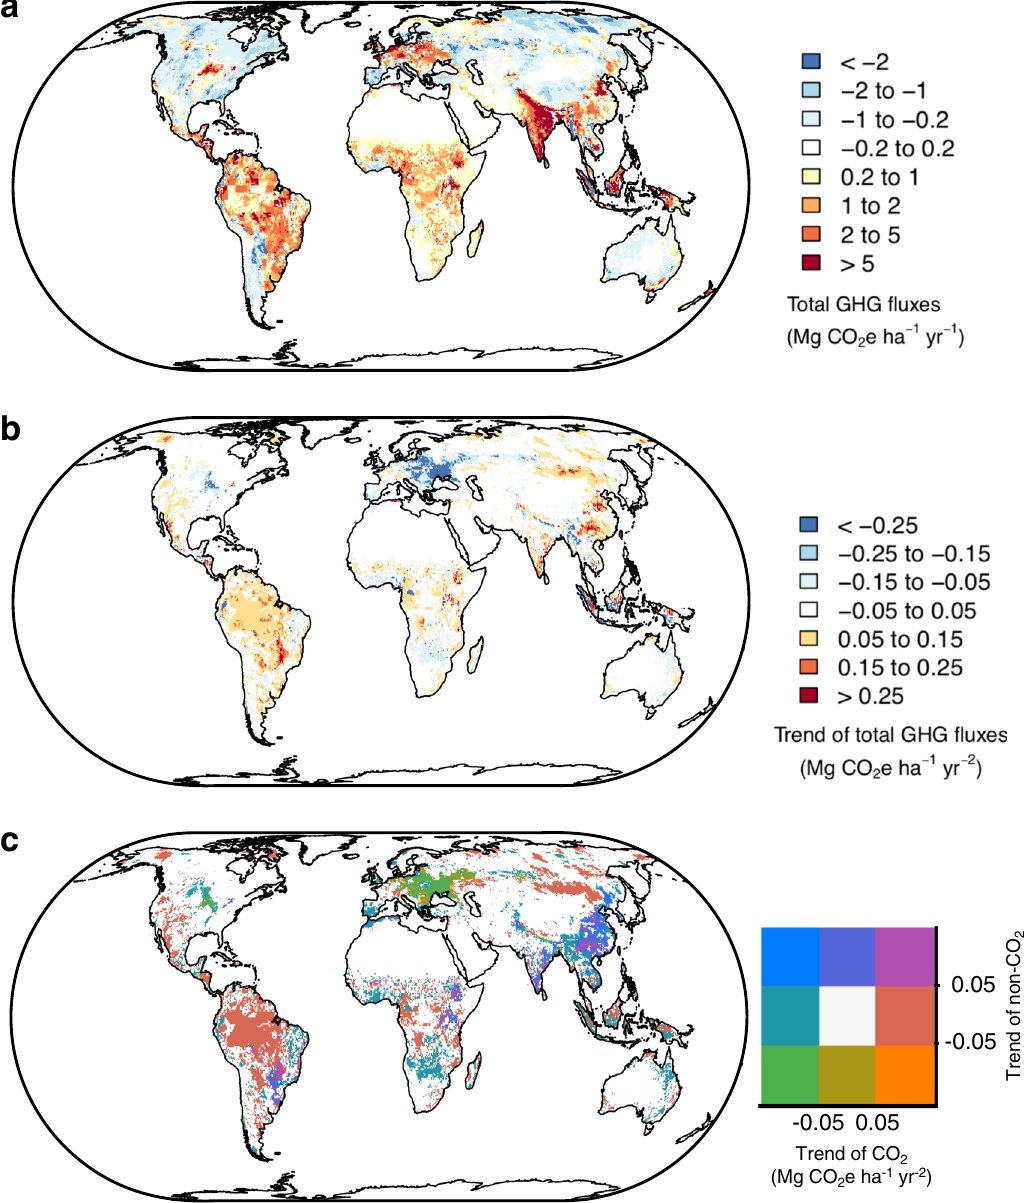
Fig. 3 Global distribution of grassland greenhouse gas (GHG) balance during the period 1981 – 2010. a Mean value, b its trend, and c the trends of CO 2 fl uxes versus non-CO fl uxes. Negative values in a , the total GHG fl uxes, indicate GHG sinks and positive values indicate GHG sources. Negative values in b , the 2 trend of total GHG fl uxes, indicate enhanced GHG sinks or decreased GHG emissions, while positive values indicate increased GHG emissions or attenuated GHG